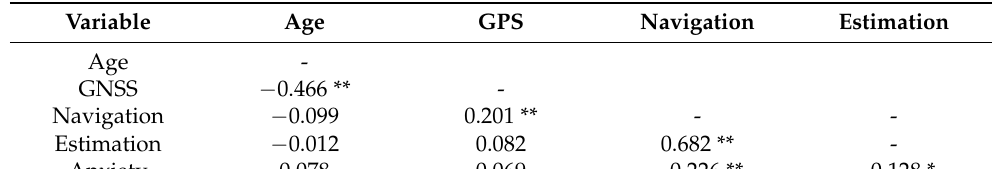
Table 2. Spearman ’ s Partial Correlations between AGE, WQ subfactors, and GNSS, conditioned by gender. ** = p < 0.001; * = p < 0.05.